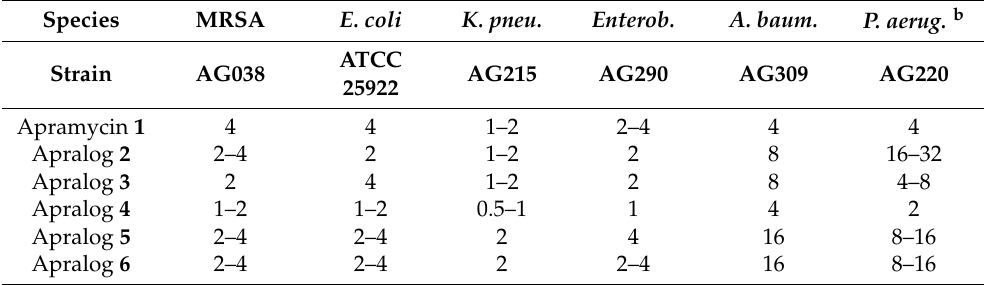
Table 2. Antibacterial Activities against Wild-Type E. coli and ESKAPE Pathogens (MIC, µ g/mL) a . Species